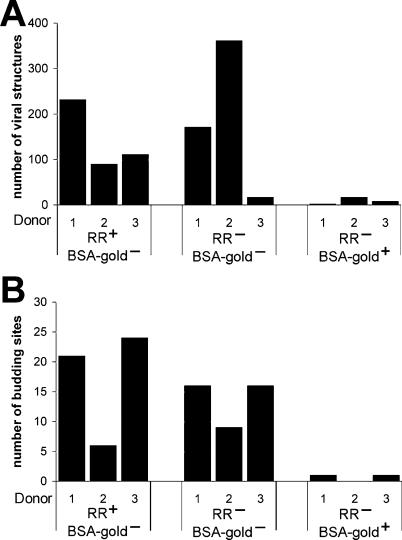
Quantification of Membrane Structures Where HIV-1 Accumulates and BudsThree types of cellular membranes, either surrounding free virus or displaying budding sites, were considered: (i) RR-positive without internalized BSA-gold (RR+, BSA-gold−), (ii) RR-negative without BSA-gold (RR−, BSA-gold−), and (iii) RR-negative with BSA-gold (RR−, BSA-gold+). No RR-positive, BSA-gold-positive structures were observed.(A) Numbers of viral structures (sum of free virus particles and budding profiles) seen on the three types of membrane structures in infected MDM prepared from three blood donors (designated 1–3). Free virus included mature virions with a typical conical core and immature particles displaying an electron dense Gag shell. Budding sites include “late buds” consisting of spherical profiles that are connected to a membrane via a stalk (see, for instance, Figure 3K and “early buds”) and half-moon-shaped membrane profiles with an electron-dense Gag shell on their concave side (see, for instance, Figure 3H).(B) Distribution of budding profiles over the same three membrane structures and of the same three donors as in (A).